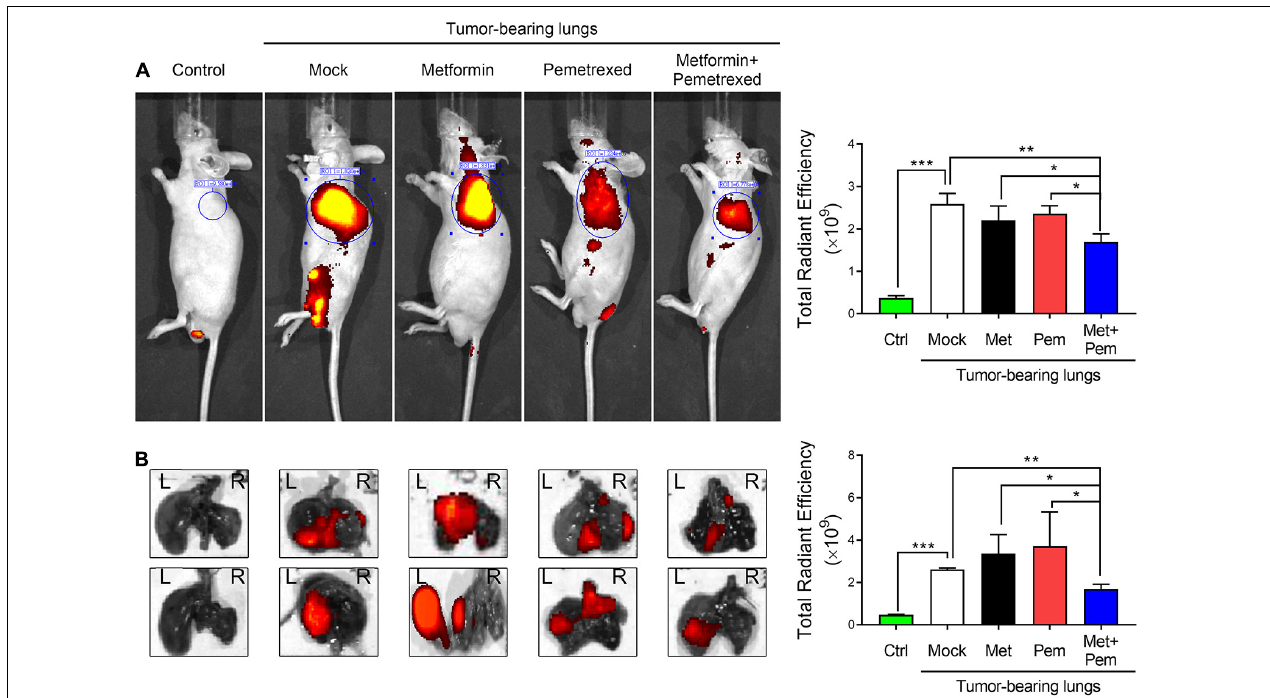
FIGURE 5 | The combination of metformin with pemetrexed exerted additive inhibitory effects on A549 cell growth in a human orthotopic NSCLC xenograft model. An orthotopic lung tumor model was established via transpleural injection of 1 × 10 6 fluorescently labeled A549 cells (iRFP-2A-Venus). After 4 weeks of A549 grafting, the mice were treated with metformin (Met; 250 mg/kg/day), pemetrexed (Pem; 150 mg/kg/twice a week) or both (Met + Pem). [ (A) left panel] After a 3-week period of drug treatment, in vivo fluorescence images were acquired using an IVIS R (cid:13) (Spectrum CT instrument) at the appropriate wavelength (iRFP: λ 650/720 nm). [ (A) right panel] Statistical bar chart shows the total radiant efficiency of the iRFP signals, which was calculated using Living Image software. [ (B) left panel] Whole lungs were excised from nude mice, and ex vivo fluorescence imaging was observed directly through the IVIS Spectrum system. [ (B) right panel] Quantitative analysis of fluorescence intensity based on ex vivo images. All images were scaled to the same minimum and maxi-mum color values. The data are presented as the mean ± SD of those from 2–3 independent experiments with two technical replicates in each. * P < 0.05, ** P < 0.01, and *** P <